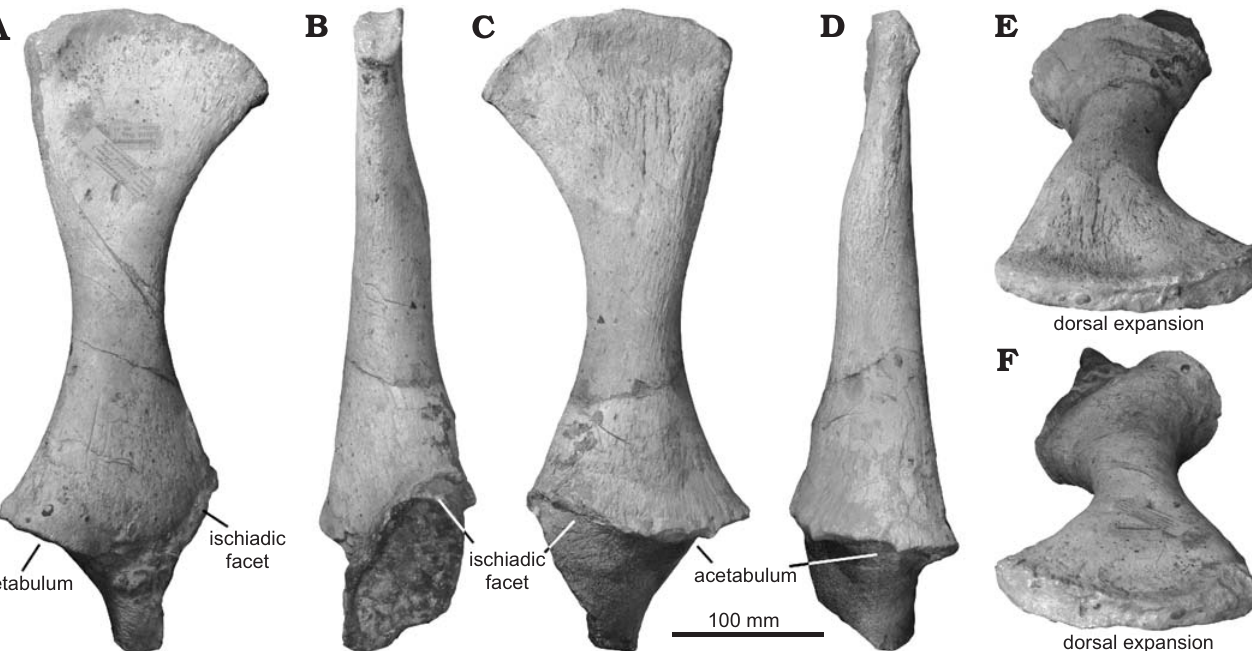
Fig. 2. Left ilium of the plesiosaur Rhomaleosauridae indet., CAMSM X.50215, from the Callovian Peterborough Member of Fletton, United Kingdom, in lateral ( A ), posterior ( B ), medial ( C ), anterior ( D ), dorsolateral ( E ), and dorsomedial ( F )